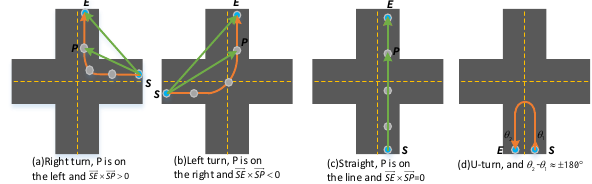
Figure 4. Schemes of turning restriction rules inference All the trajectories in cluster C are judged one by one according to the above schemes. The final turning rule of cluster C is selected as the one with the largest percent. Actually, one intersection may have several turning modes or trajectory clusters, and thus contain multiple turning restriction rules. Figure 3. Two tracks for example and definition of the turning function of two tracks